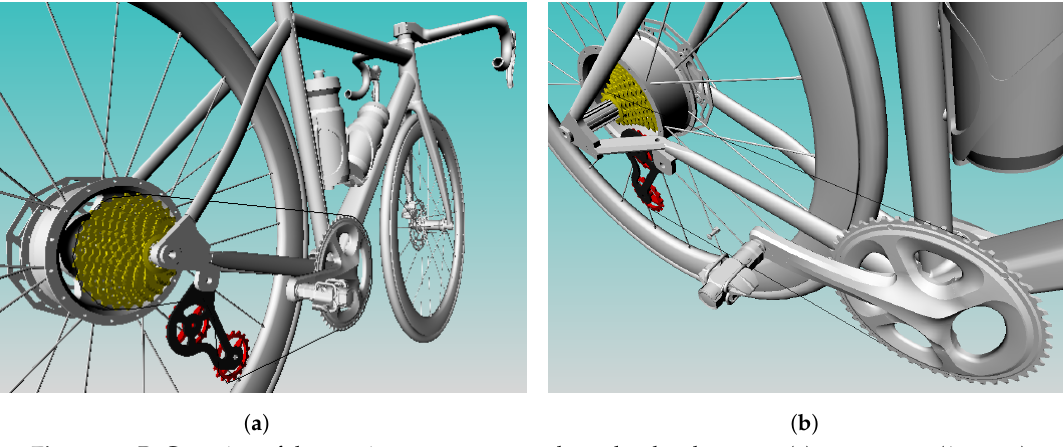
Figure 10. PoC version of the moving cassette currently under development: ( a ) cassette out (1st gear); and ( b ) cassette in (12th